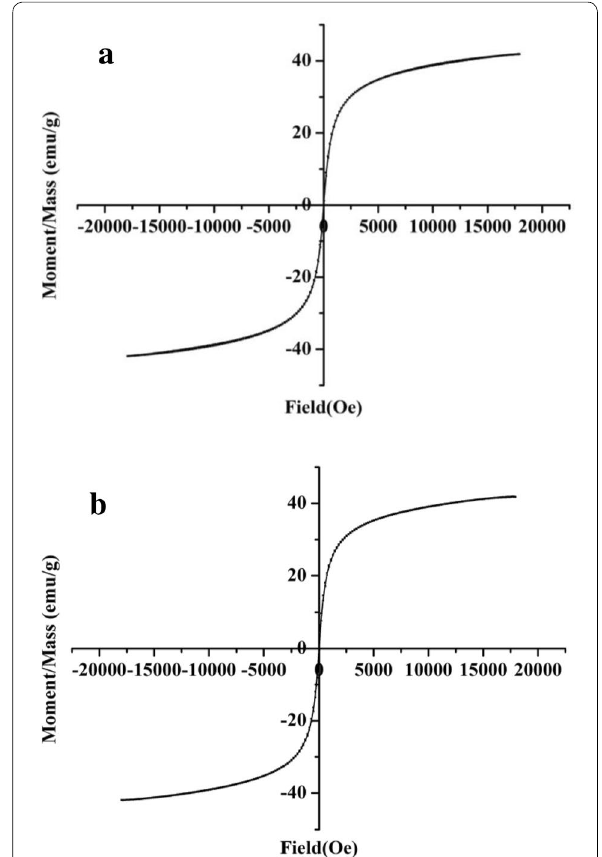
Fig. 3 VSM images of magnetic Fe 3 O 4 nanoparticles ( a ) and amino-functionalized Fe 3 O 4 nanoparticles ( b ). The hysteresis loop of the both nanoparticles revealed a ferromagnetic behavior and the remanence and coercive force was near to zero